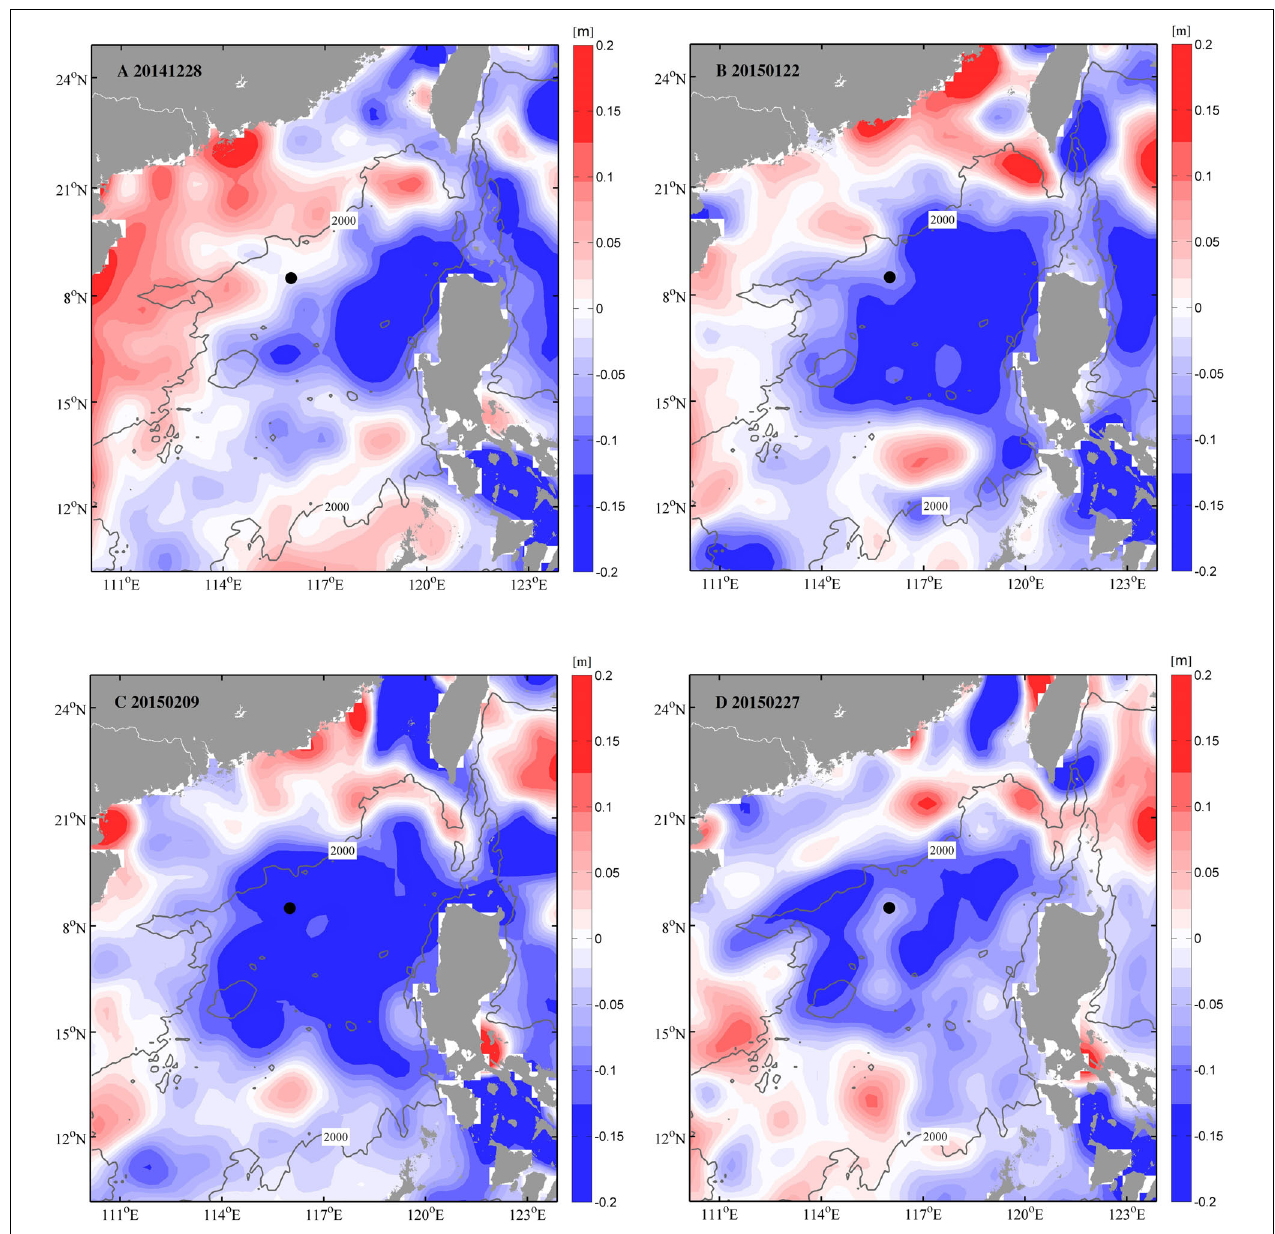
FIGURE 5 | Satellite images of daily sea surface height anomaly (SSHA, m) in northern SCS from AVISO product on (A) December 28, 2014, (B) January 22, 2015, (C) February 09, 2015, and (D) February 27, 2015, exhibiting cyclonic eddy activity during winter period of 2014–2015 in study area. Dots on map represent 1/4 ◦ × 1/4 ◦ grid around station SCS-N and gray line with label 2,000 indicates water isobaths of 2,000